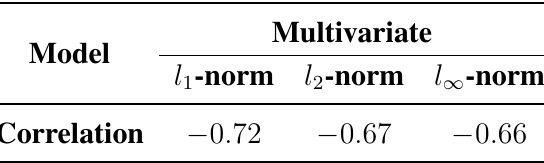
Table 5. Pearson correlation between Euclidean distances δ to the origin of the trade-off curve and the F-measure for different norms.